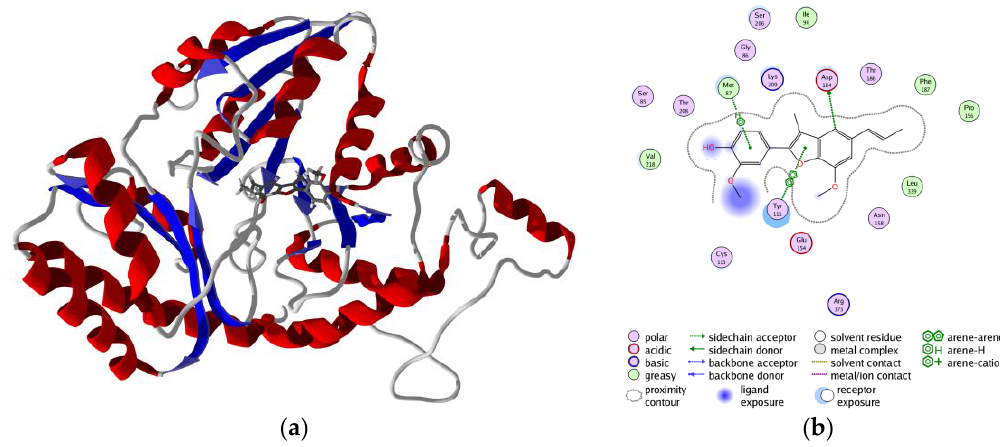
Figure 10. Lowest-energy docked pose of eupomatenoid-7 with Trichomonas vaginalis methionine gamma-lyase (TvMGL): ( a ) ribbon diagram of TvMGL with eupomatenoid-7; ( b ) ligand-receptor interaction map of eupomatenoid-7 with TvMGL.